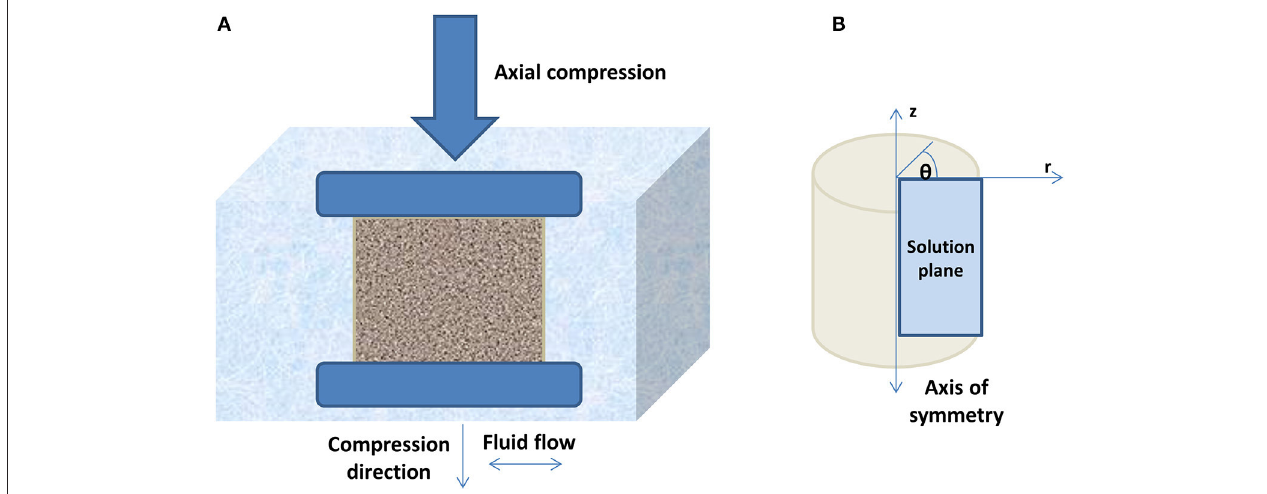
FIGURE 1 | (A) A central cross-section through an unconfined cylinder of a poroelastic material subjected to a sustained uniaxial compression between two rigid, frictionless impermeable and parallel plates. (B) The relaxation problem is solved on the cylindrical polar coordinate system using an axisymmetric finite element modeling (FEM) simulation, on the indicated right half plane only. The solution that describes the behavior of the entire cylinder could be obtained by rotating the solution plane through θ , the angle around the axis of symmetry of the cylindrical sample. The direction of the axial compression is defined to be along the z-axis and the radial fluid flow along the